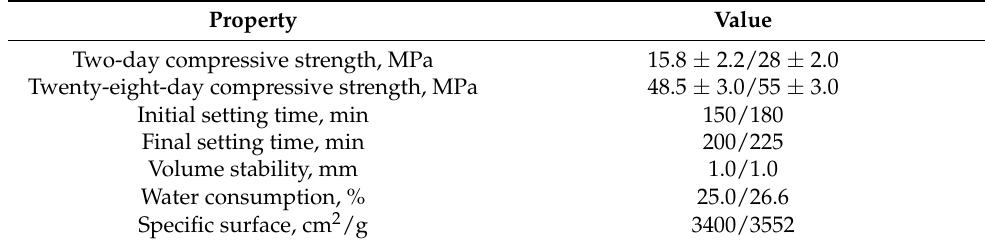
Table 2. Physical and mechanical properties of